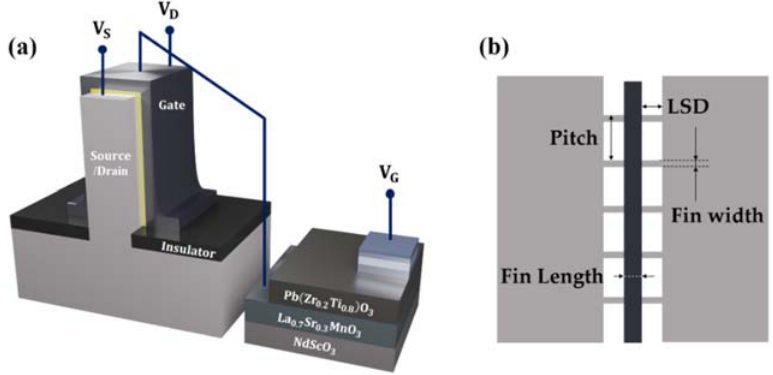
e ff ect transistor).